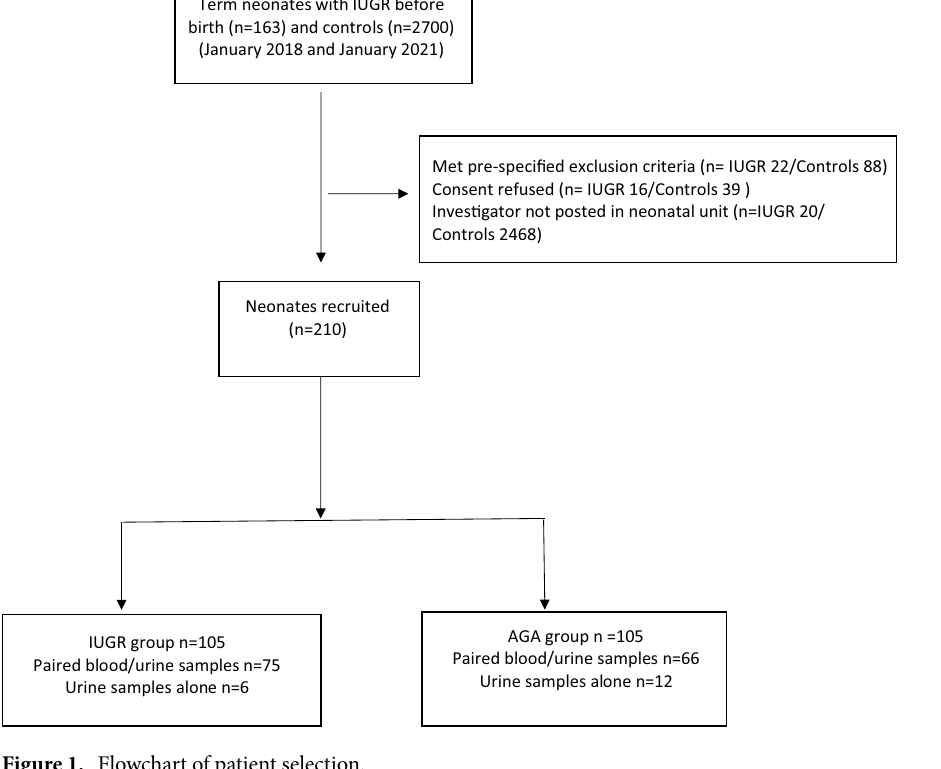
Figure 1. Flowchart of patient